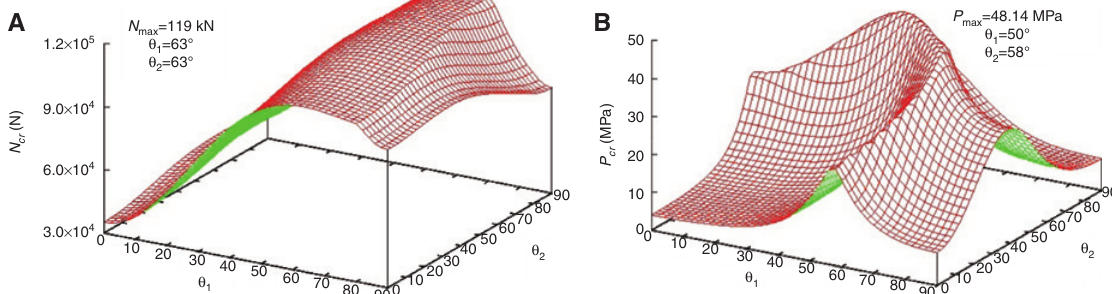
Figure 2: Variation of the buckling load in a rectangular plate and the critical pressure in a cylindrical pressure vessel depending on the fiber orientation. Case of two